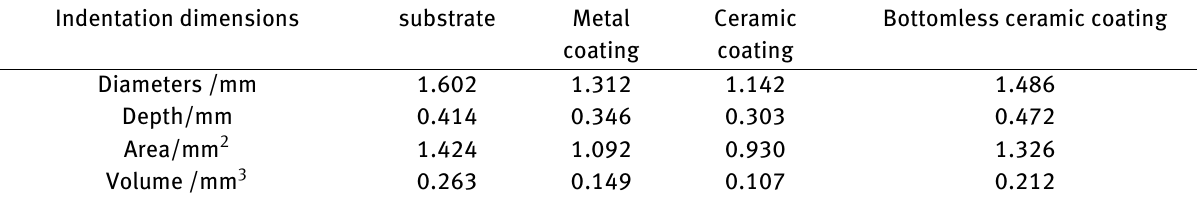
Table 2: Indentation dimensions of coating